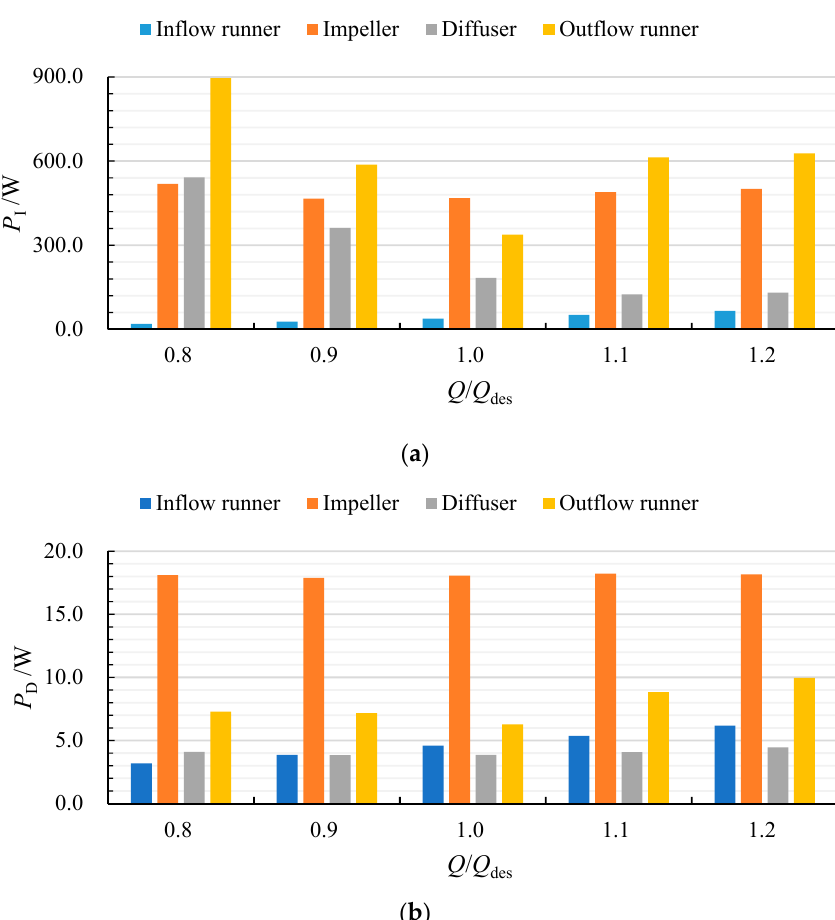
Figure 8. Distribution of ( a ) power loss due to indirect dissipation and ( b ) power loss due to direct dissipation of different hydraulic components without root clearance under five flow rates. Processes 2020 , 8 , x FOR PEER REVIEW